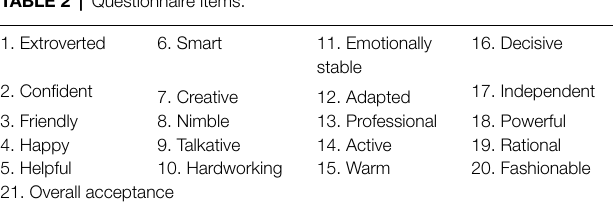
TABLE 2 | Questionnaire